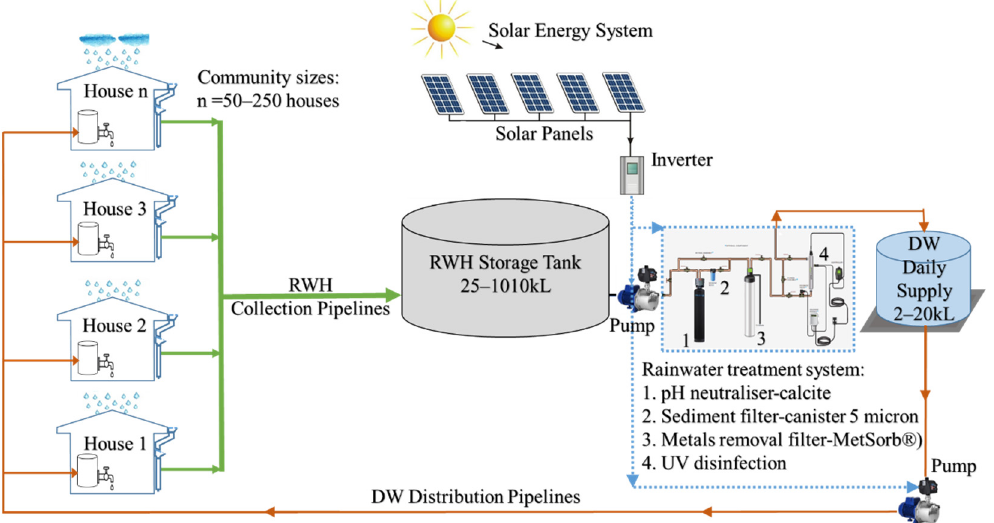
Figure 3. Illustration of community-scale RWH system for drinking water supply.